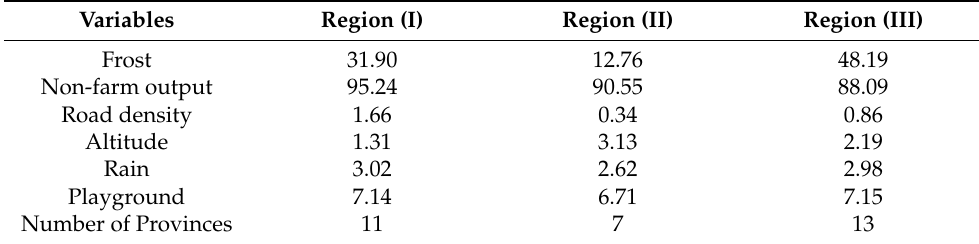
Figure 4. Regional clustering of factors influencing Chinese adolescents’ physical fitness. Table 5. Properties of the various influence